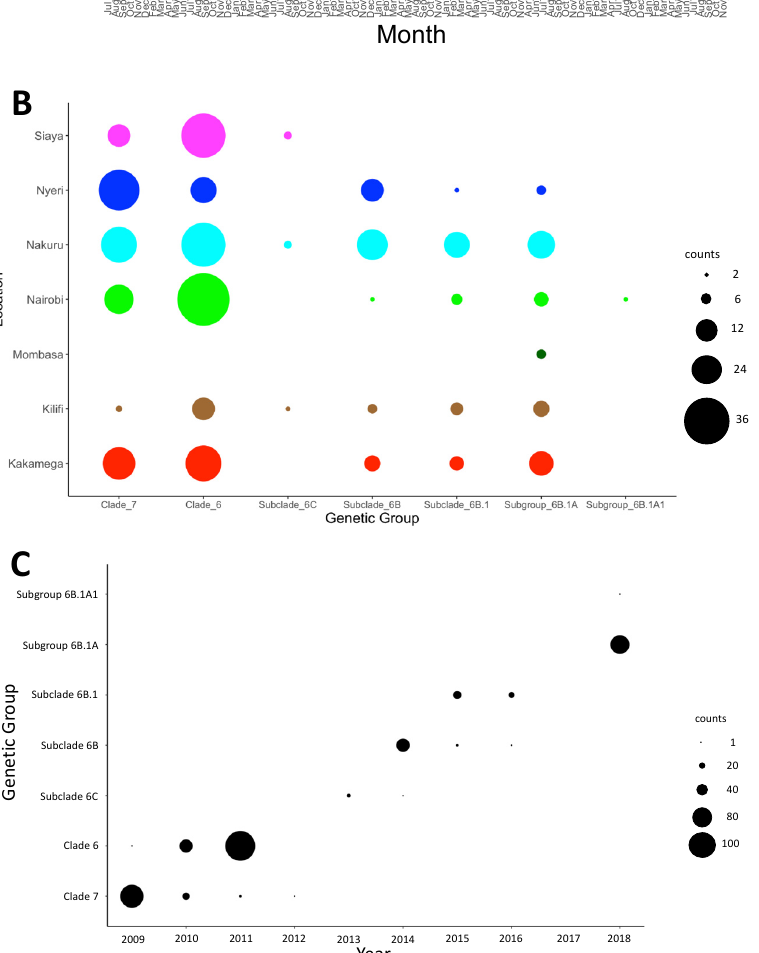
Figure 1. Distribution of influenza A(H1N1)pdm09 virus in Kenya, 2009–2018. ( A ) Bar plot showing number of A(H1N1)pdm09 virus-positive samples and sequenced positive samples by month between July 2009 and November 2018 in Kenya. All collected A(H1N1)pdm09 virus- positive samples and sequenced samples are indicated by color (all positive samples in gray— H1N1pdm09_notSequenced; sequenced samples in black—H1N1pdm09_Sequenced) as shown in the color key. ( B ) Bubble plot showing the distribution of genetic groups by location in Kenya, 2009–2018. ( C ) Distribution of genetic groups by surveillance year in Kenya, 2009–2018. The size of the circles in panels ( B , C ) is proportional to the number of samples, as shown in the counts key for the